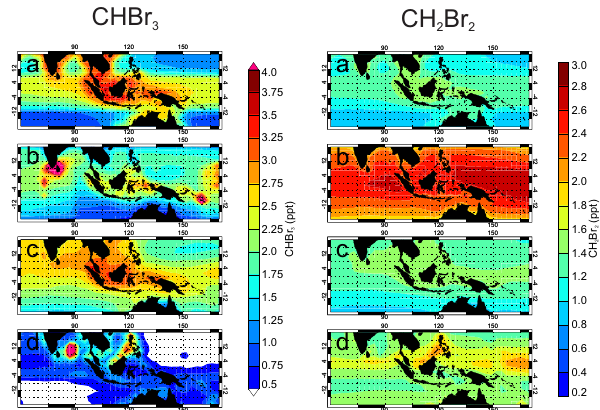
Fig. 9. Modelled mean surface mixing ratio (ppt) of CHBr 3 (left column) and CH 2 Br 2 (right column) over the tropical western Pacific during 2011 for CTM runs (a) S Liang , (b) S Warwick , (c) S Ordonez and (d) S Ziska